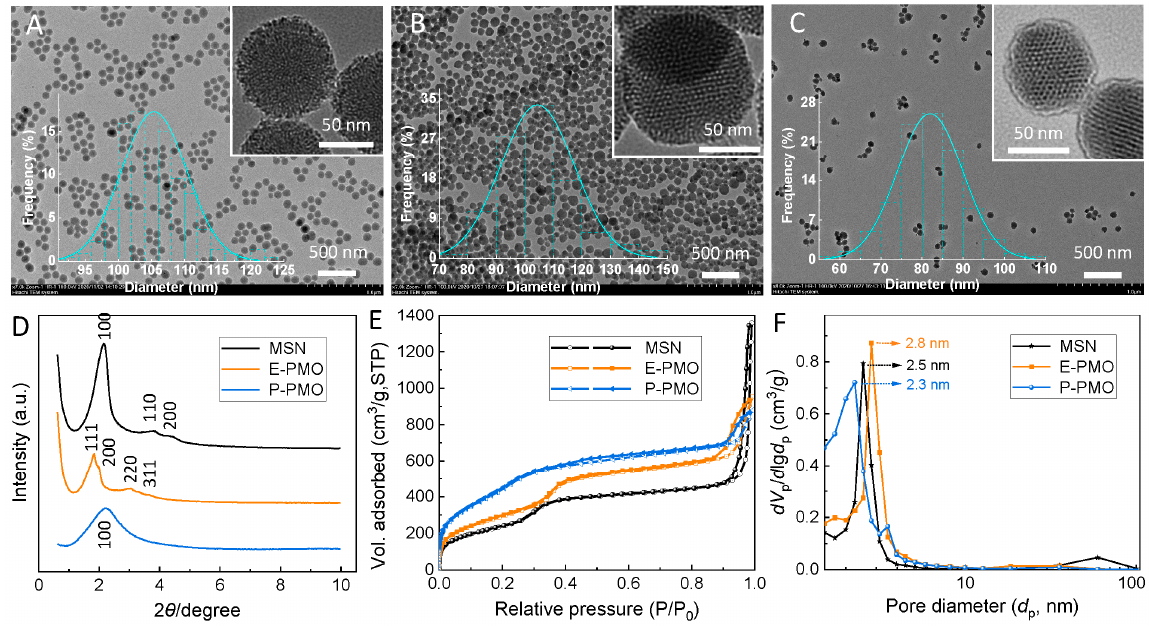
Figure 1. Structure characterization of three representative porous nanomaterials. TEM images of ( A ) P ‐ PMO ( d TEM = 105.4 ± 4.9 nm), ( B ) E ‐ PMO ( d TEM = 104.4 ± 14.4 nm), ( C ) MSN ( d TEM = 81.9 ± 7.9 nm), and histograms of the distribution of particle diameters (based on measurements of ~100 individual particles) as inlays. ( D ) Powder XRD patterns, ( E ) BET nitrogen adsorption–desorption isotherms measured at 77 K and ( F ) the corresponding BJH pore size distribution curves calculated using the BJH method (adsorption branch). Hollow and solid points represent adsorption and desorption data,